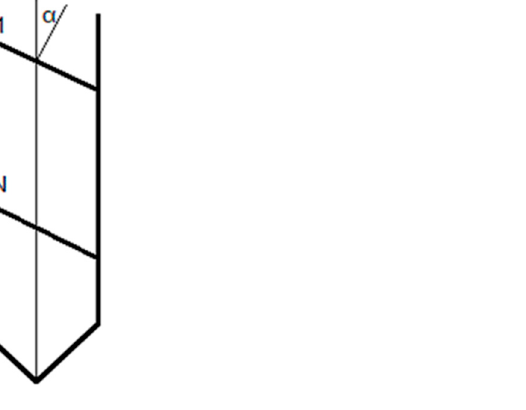
Figure 5. Outline of the ingot in the ampoule with [111] wafers orientation. The atomic fraction (at.) of Cd, Zn, and Te (EPMA) of a [111] CZT wafer is plotted in